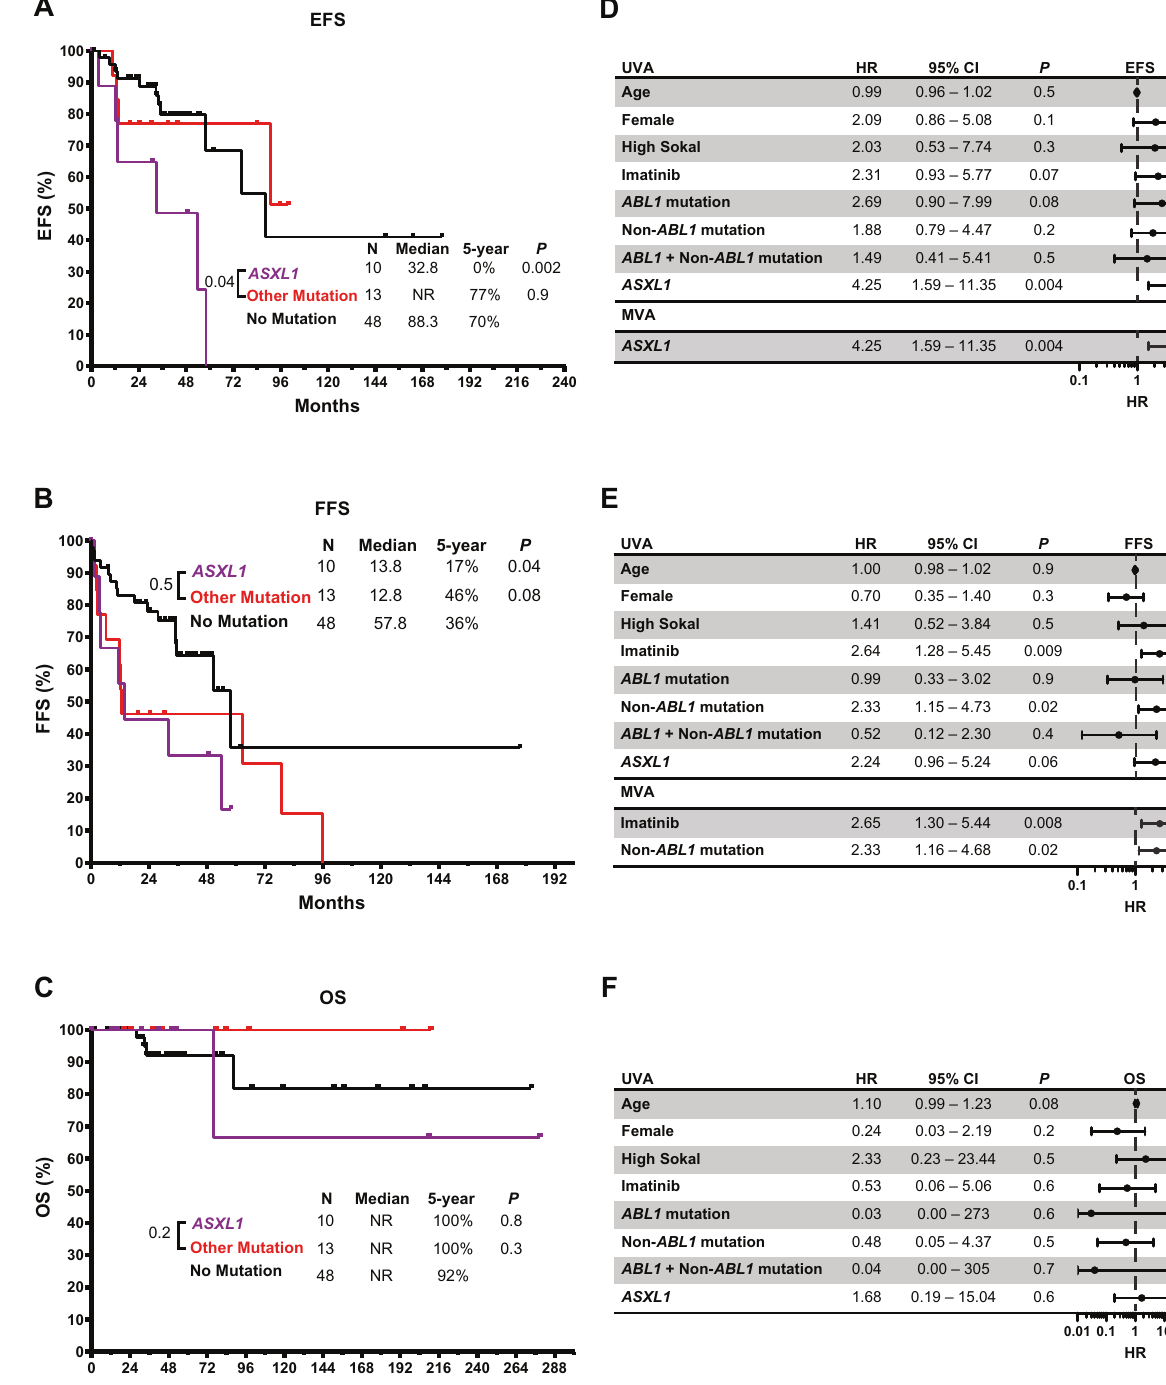
Fig. 2 Impact of ASXL1 mutations on survival in patients with CP-CML. A Event-free survival (EFS). B Failure-free survival (FFS) and C overall survival (OS) comparing patients with mutations in ASXL1 vs mutations in other genes or no mutation. Univariate (UVA) and multivariate (MVA) analyses of factors predicting: D EFS, E FFS, and F OS. m factors associated with worse FFS (Fig. 2E). Advanced phase CML Fifteen patients with AP-CML and 29 patients with BP-CML had mutational analysis performed (Supplemental Tables 2 and 3). Among the 15 patients with AP-CML, 10 (67%) had at least one